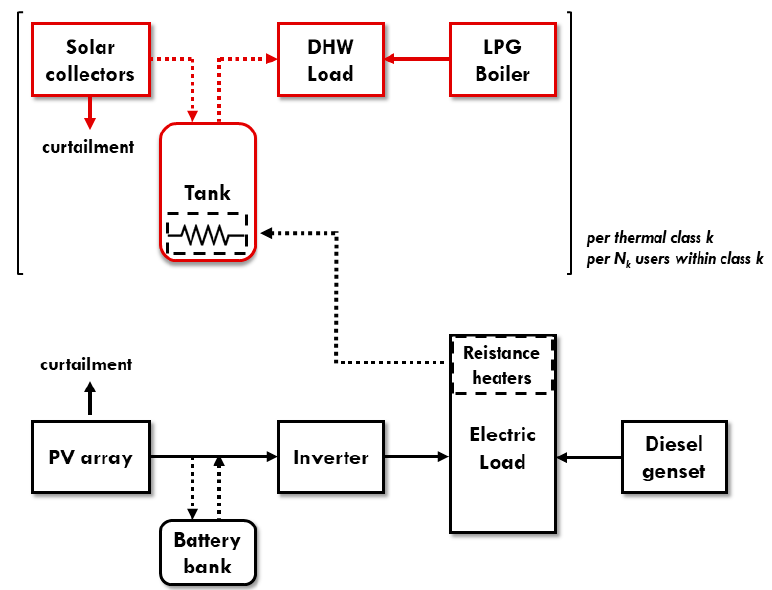
Table 1. Main inputs and outputs of the Multi-Energy System model.